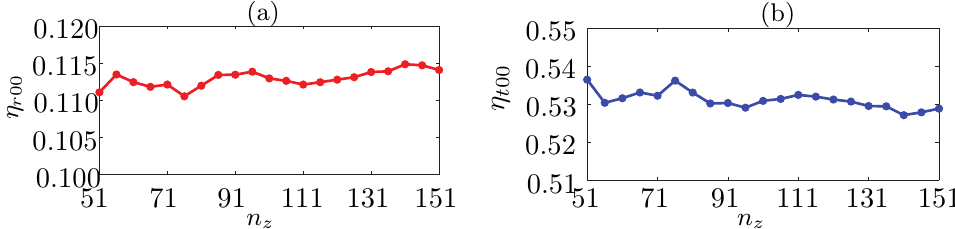
Figure A3. Diffraction efficiencies ( a ) η r 00 of the zeroth reflected order and ( b ) η t 00 of the zeroth transmitted order plotted against the number of layers n z in the FMM